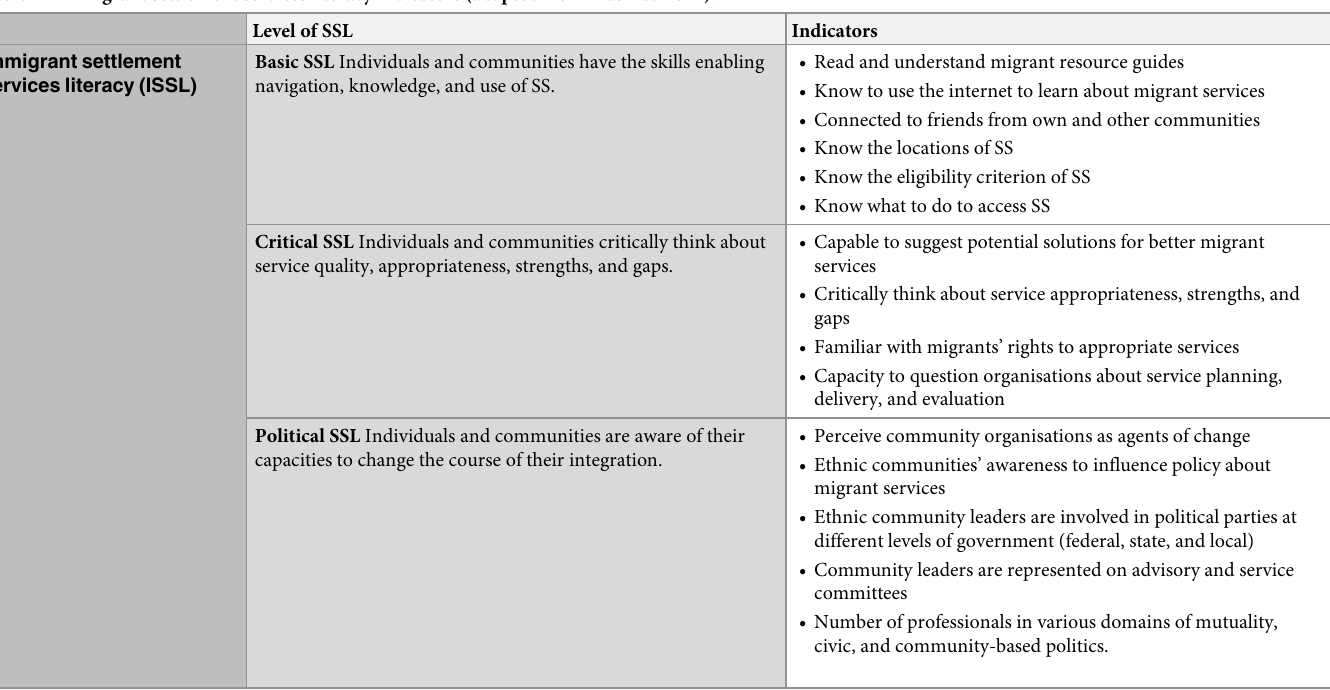
Table 1. Immigrant settlement services literacy indicators (adapted from Masinda